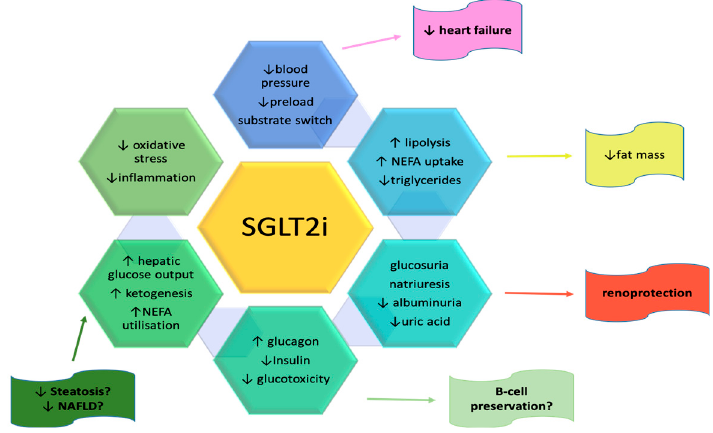
Figure 1. Bene fi ts of SGLT2 inhibitors. (“ ↑ ”: increase; “ ↓ ”: decrease; SGLT2i: sodium-glucose co- transporter 2 inhibitors; NAFLD: non-alcoholic fa tt y liver disease; NEFA: nonesteri fi ed fa tt y acids) [84].